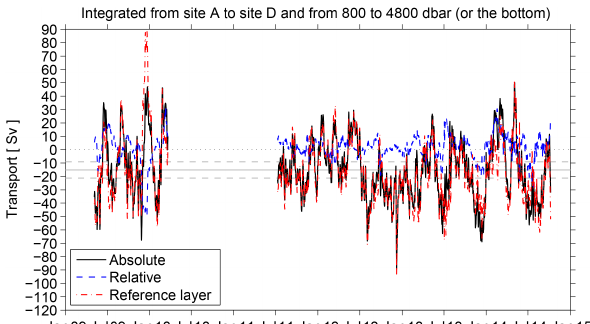
Figure 6. Time series of DWBC volume transport determined across the full horizontal span of the array and integrated vertically from 800 to 4800dbar (or the bottom for areas where it is shal- lower). The total absolute transport is shown (black solid), as are the components relative to an assumed level of no motion at 800dbar (“Relative”; blue dashed) and associated with the actual reference layer flow (“Reference Layer”; red dash–dot). The gray horizontal solid and dashed lines respectively indicate the time mean and the time mean plus or minus two standard errors of the mean (i.e., the 95% confidence limit for the mean value). Standard errors were de- termined following commonly used methods (e.g., Dewar and Bane,